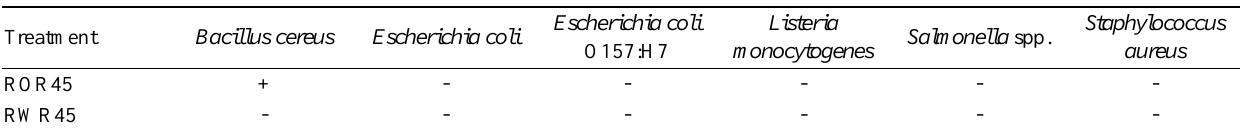
Table 4. Qualitative evaluation for Bacillus cereus , Escherichia coli , Listeria monocytogenes , Salmonella spp. and